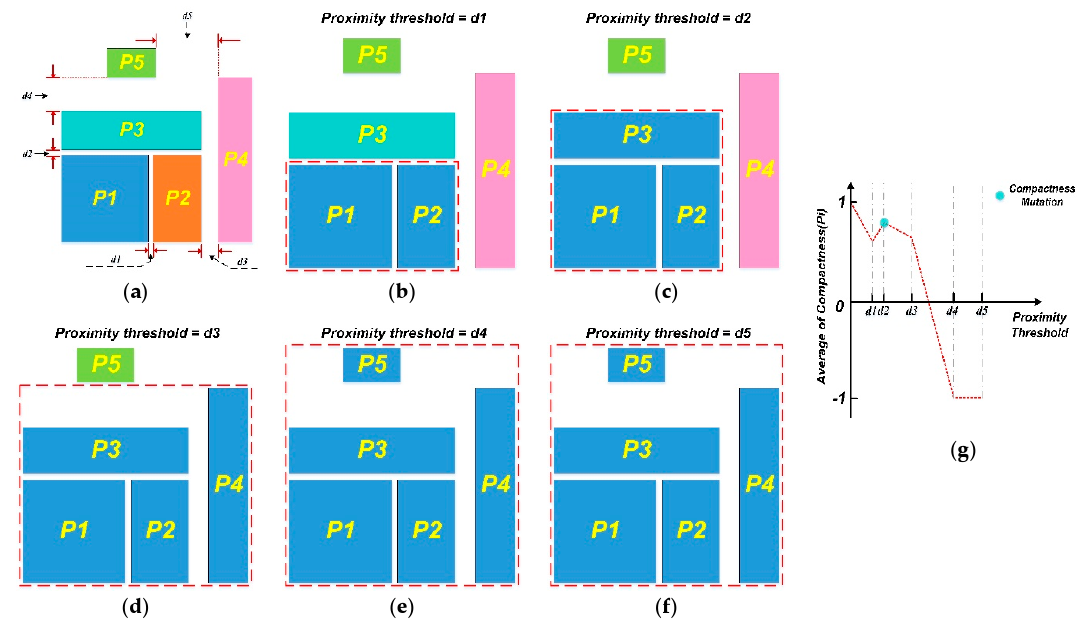
Figure 10. Illustration of grouping results with different proximity thresholds: ( a ) ungrouped parcels; ( b ) proximity threshold = d1; ( c ) proximity threshold = d2; ( d ) proximity threshold = d3; ( e ) proximity threshold = d4; ( f ) proximity threshold = d5; ( g ) the relationship between compactness and proximity threshold. Table 3. Description of relationship between proximity threshold and compactness.